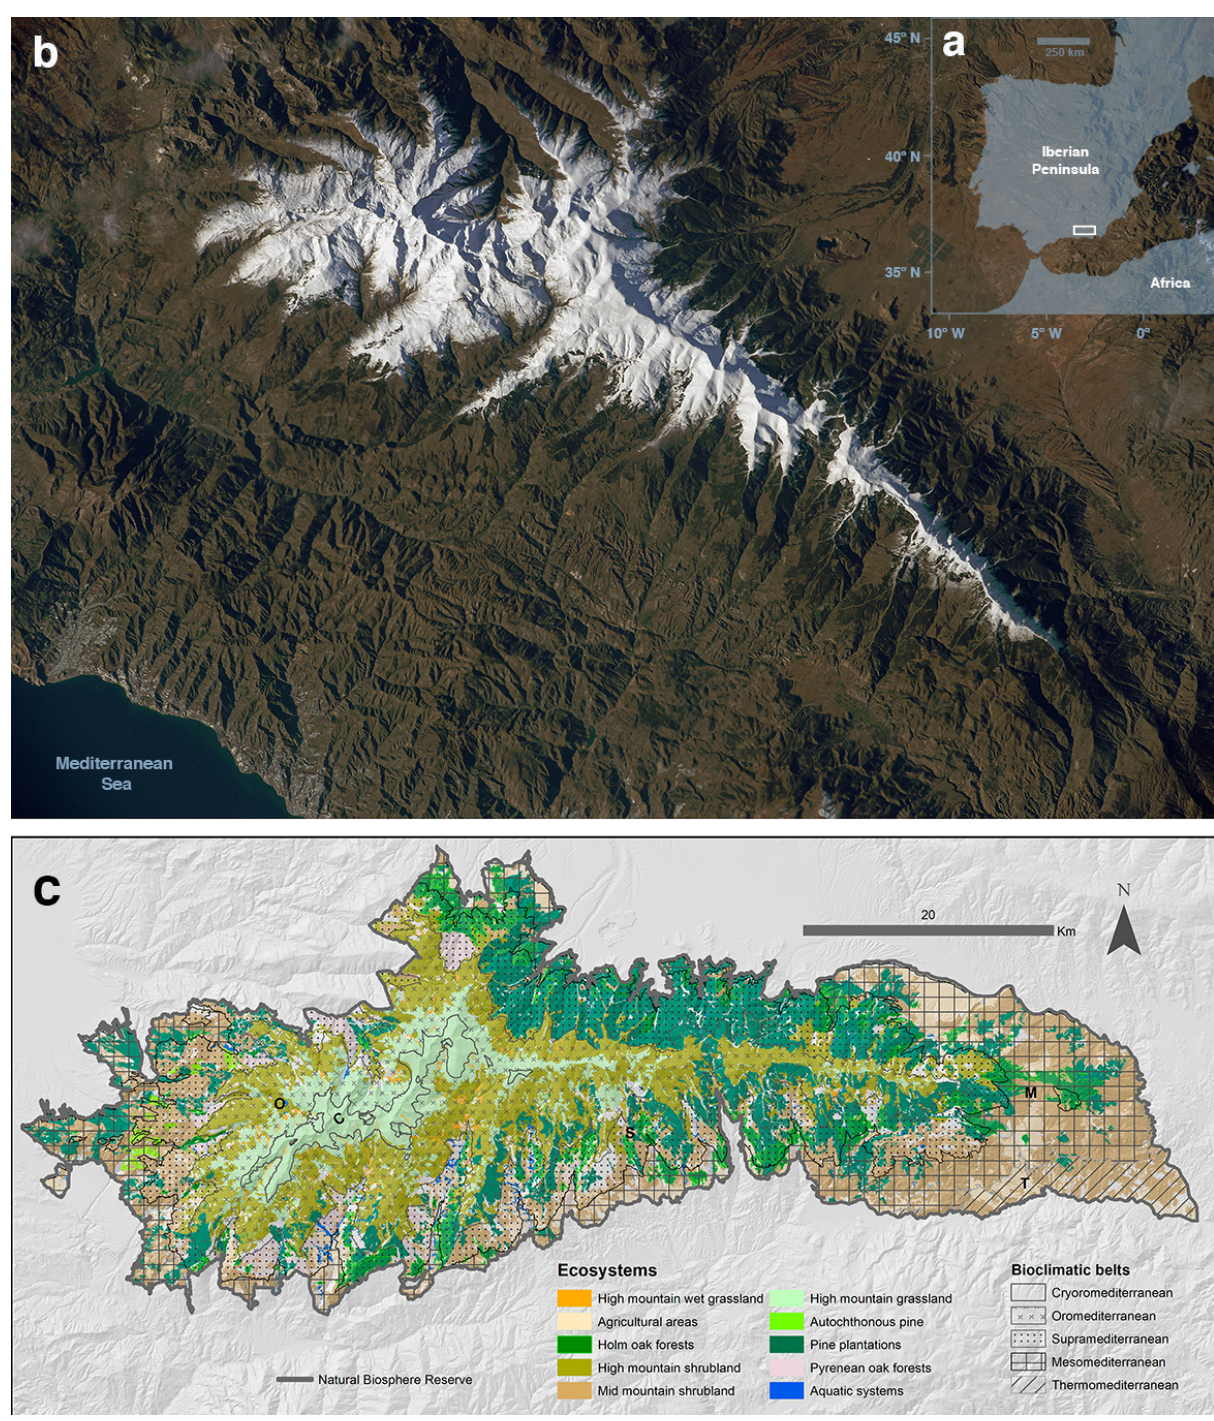
Figure 1. Study area: Sierra Nevada Biosphere Reserve. (a) Location in the context of the Iberian Peninsula; (b) remote view of the Sierra Nevada region (image from the International Space Station taken in December 2014, courtesy of the Earth Science and Remote Sensing Unit, 615 NASA Johnson Space Center); (c) delimitation of the Biosphere Reserve and the distribution of the main ecosystems (Pérez-Luque et al., 2019) and thermotype bioclimatic belts (Molero and Marfil, 2015).